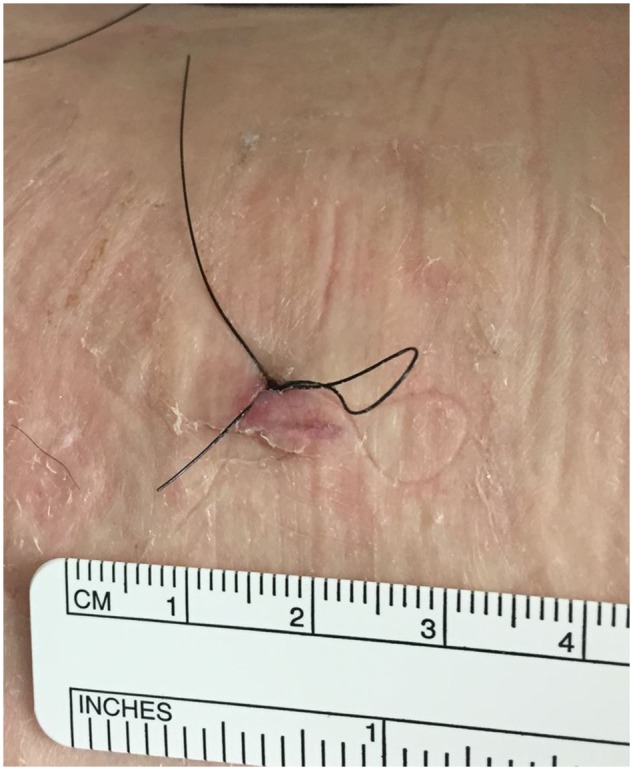
Loop suture closure used to close portals [11].